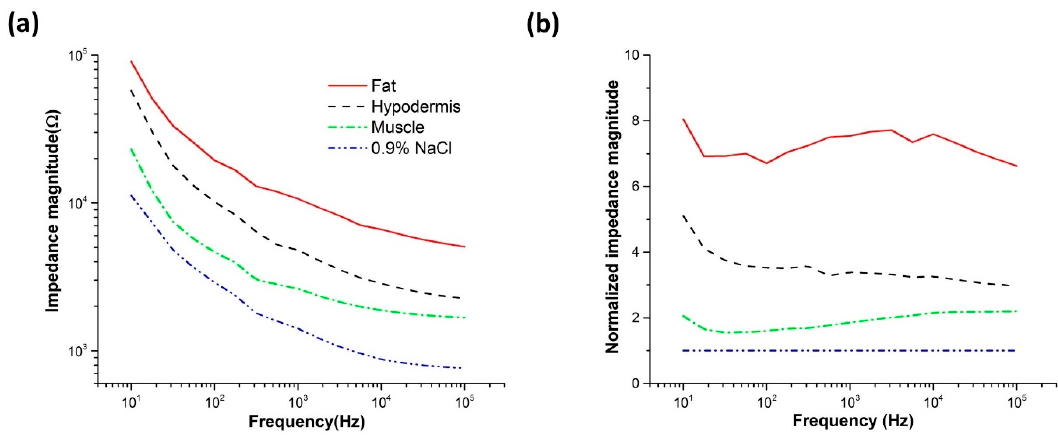
Figure 6. ( a ) Impedance magnitude and ( b ) normalized impedance magnitude spectra at different tissue layers of pork meat at frequencies from 10 Hz to 100 kHz. tissue layers of pork meat at frequencies from 10 Hz to 100